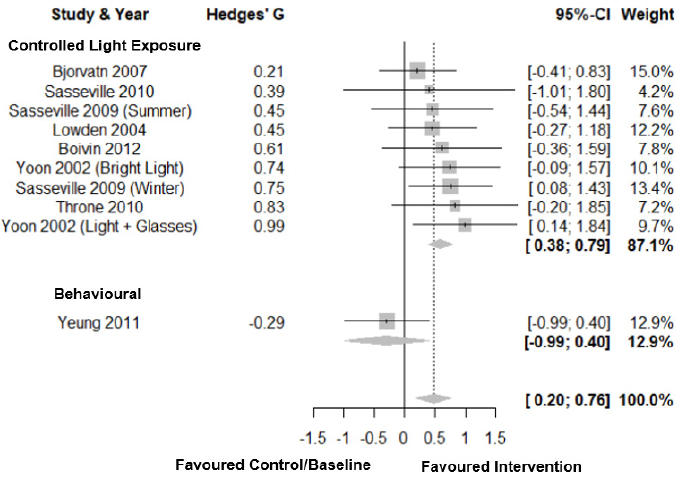
Figure 6. Forest plot intervention by type on sleep efficiency. Note. Interventions with multiple conditions are denoted within brackets.